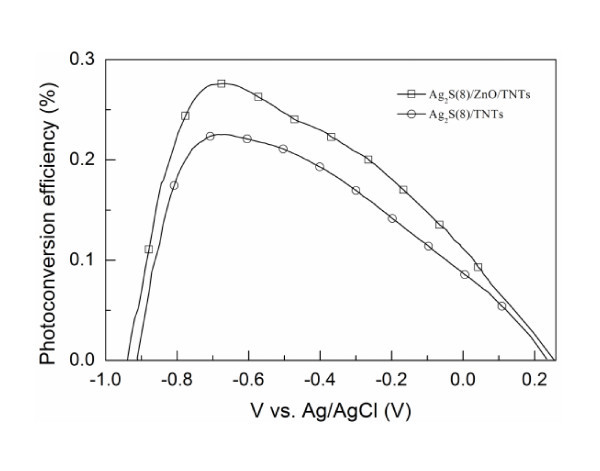
The photoconversion efficiencies of the Ag2S(8)/ZnO/TNT and Ag2S(8)/TNT electrodes.